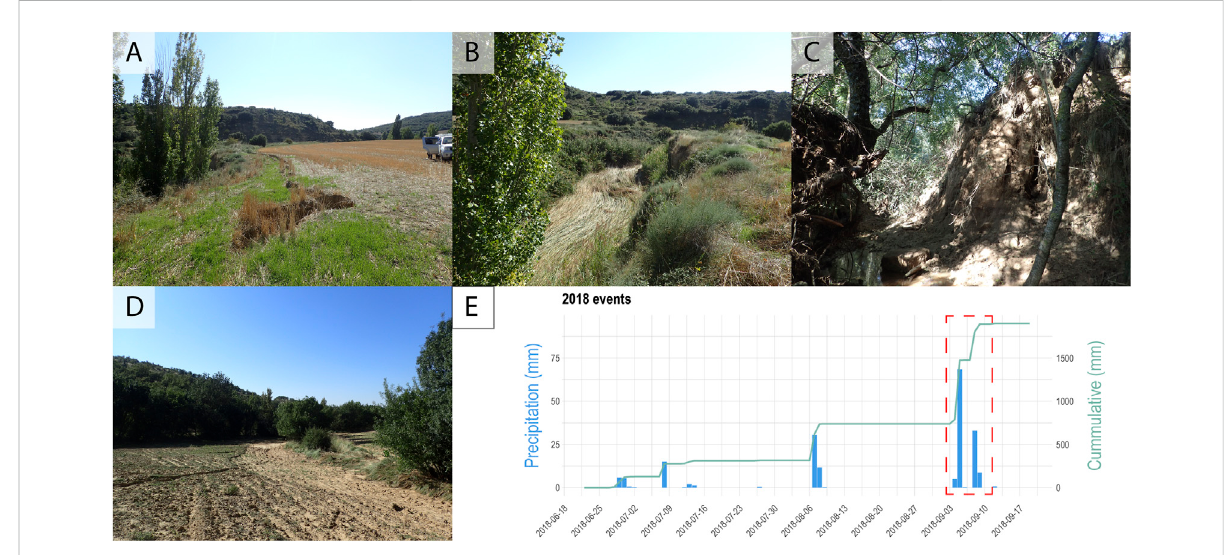
FIGURE 8 (A – D) Images showing the impacts on thestudy area after the two heavy precipitation events of September 2018. (E) Historical intraday data of summer 2018, highlighted with a red-dashed line square, the two heavy precipitation events occurred between 05/09/2018 with 68.4 l and 07/09/ 2018 with 30.6